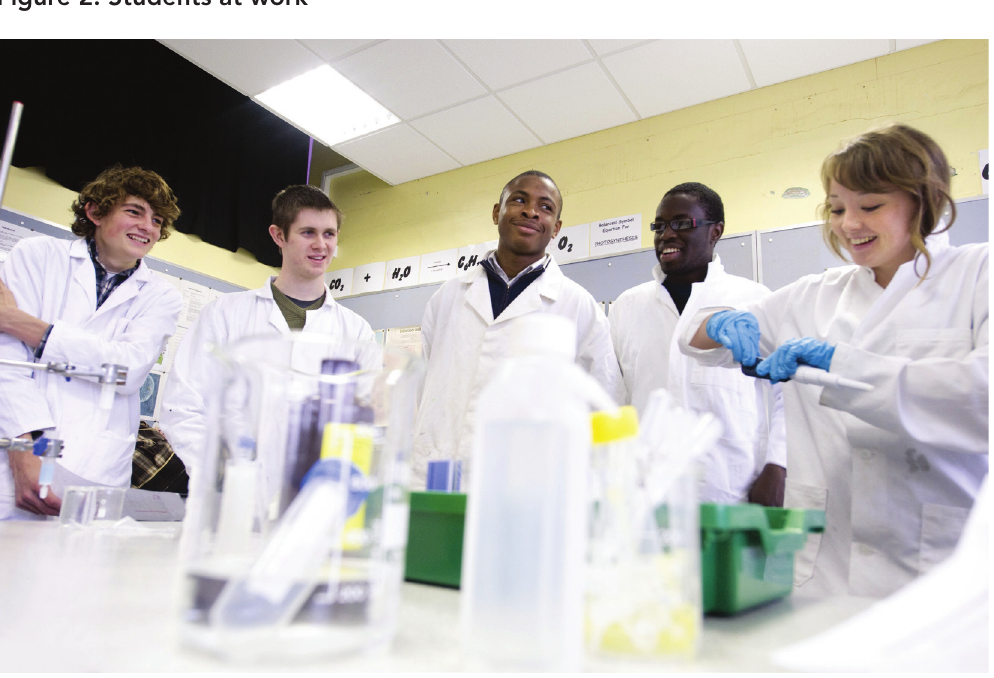
Credit: Wellcome